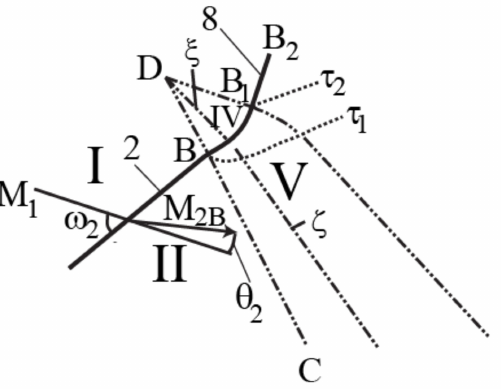
Figure 2. Oblique shock interaction with an expansion fan (fragment of Figure 1a with additional symbols). Here, I is the flow region downstream of the incident shock ( M 1 is the flow Mach number in that zone); II is the flow region downstream of the reflected shock 2; IV is the rear expansion fan ( D is its center; ξ is its voluntary straight second-family characteristic); V is the refracted expansion fan ( ζ is its voluntary second-family characteristic); BB 1 is the curvilinear shock under influence of wave IV; 8 ( B 1 B 2 ) is the resulting shock after that influence; τ 1 and τ 2 are weak tangential discontinuities that border a shear layer between them; ω 2 and θ 2 are, correspondingly, the slope angle and